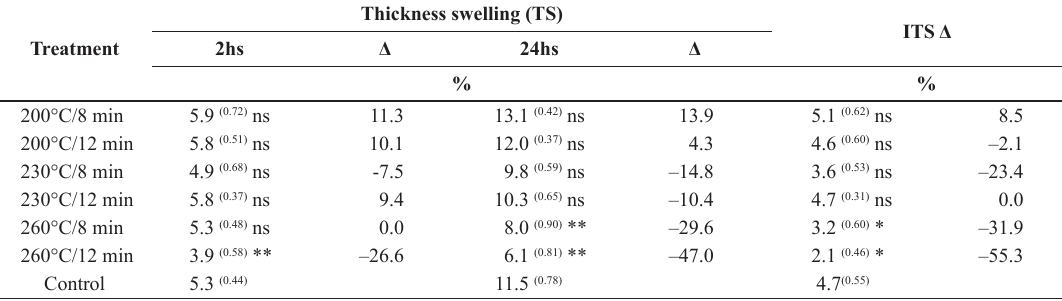
Table 6. Panel thickness swelling and irreversible thickness swell rate.